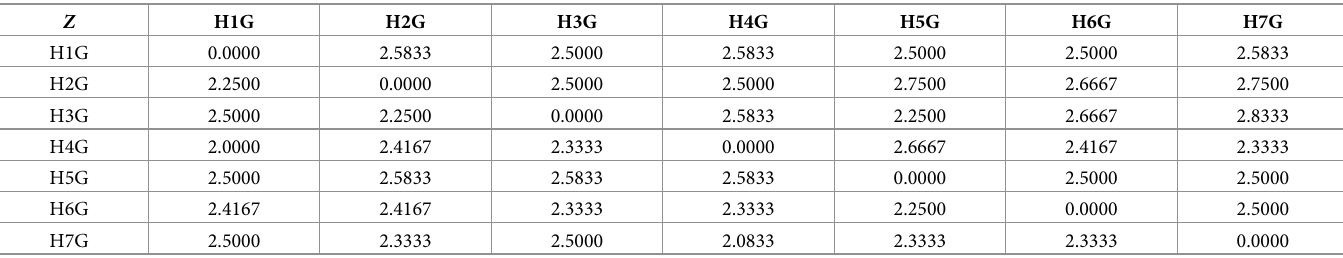
Table 2. The DEMATEL initial direct-relation matrix.